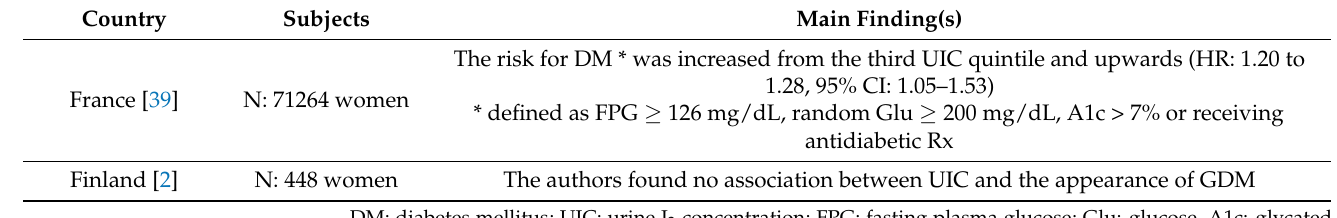
Table 2. Selected studies not showing a beneficial effect of I 2 on glycemic